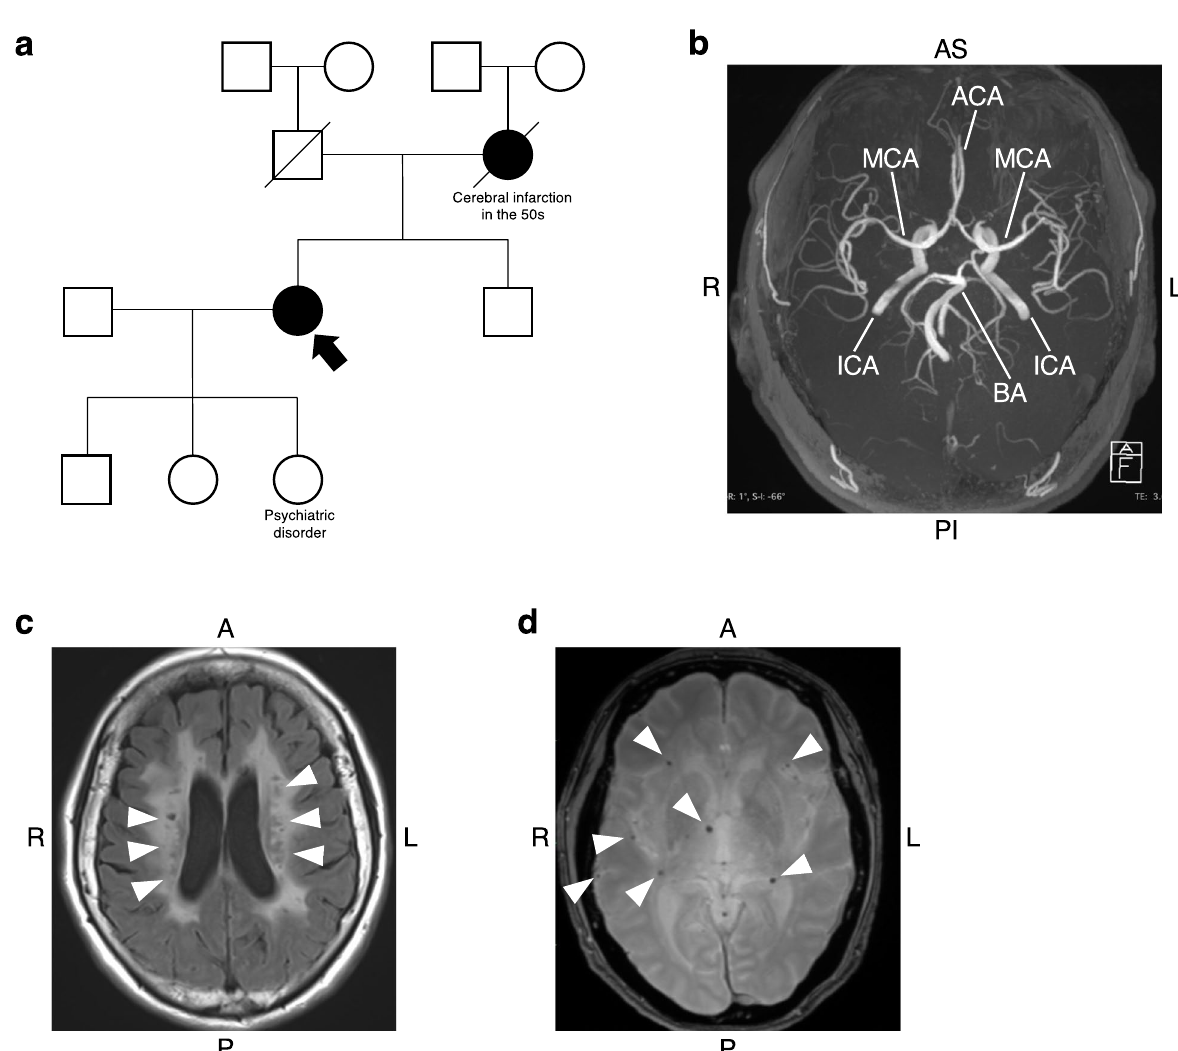
Fig. 1 Clinical findings of the patient carrying the heterozygous HTRA1 mutation. a Family pedigree of the patient with heterozygous HTRA1 -related CSVD. Squares, men; circles, women; filled symbols, individuals with a history of a stroke; a filled arrow, the donor for iPSC establishment; diagonal lines through symbols, deceased members. b Image of magnetic resonance angiography (MRA) acquired at the age of 69. ACA; anterior cerebral artery, MCA; middle cerebral artery, ICA; internal carotid artery, BA; basilar artery, L, left; R, right; AP, anterior superior; PI, posterior inferior. c . Fluid-attenuated inversion recovery (FLAIR) image of the brain magnetic resonance imaging (MRI) acquired at the age of 69. Ischemic changes are indicated by arrowheads. L left; R, right; A, anterior; P, posterior. d . T2*-weighted Image (T2*WI) of the brain MRI acquired at the age of 69. Microbleeds are marked with